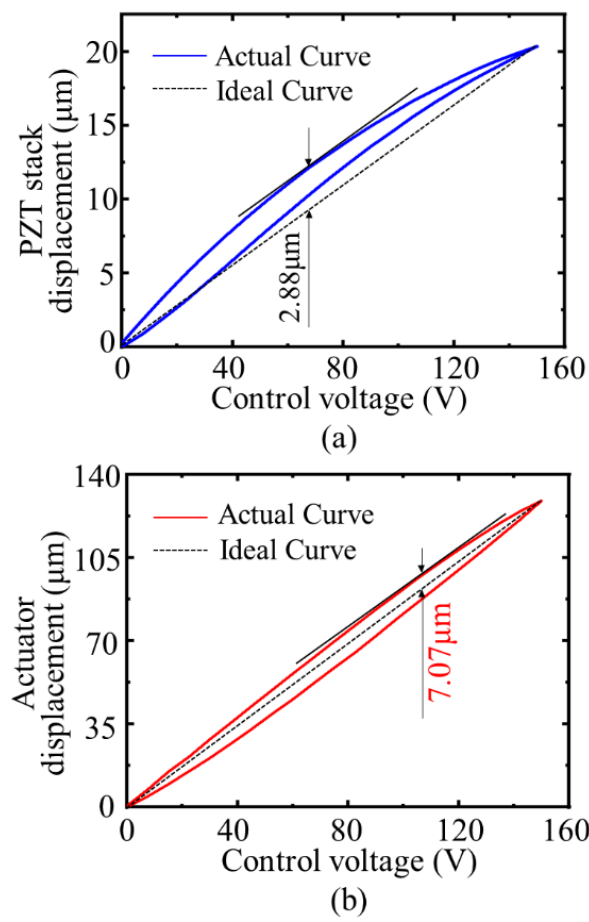
Figure 13. Hysteresis comparison: ( a ) hysteresis loop of the PZT stack; ( b ) hysteresis loop of the actuator.